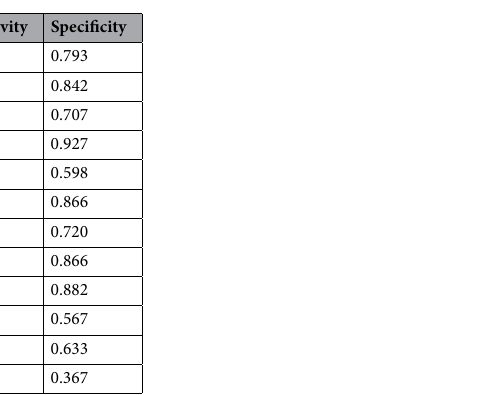
Figure 4. The diagnostic value of hsa_circ_0006423 and miR-492 in NSCLC. ( A ) AUC of hsa_circ_0006423 preoperative and healthy control groups in plasma samples. ( B ) AUC of hsa_circ_0006423 postoperative and healthy controls groups in plasma samples. ( C ) AUC of hsa_circ_0006423 preoperative and postoperation groups in plasma samples. ( D ) AUC of miR-492 preoperative and healthy control groups in tissue samples. ( E ) AUC of miR-492 postoperative and healthy controls groups in plasma samples. ( F ) AUC of miR-492 preoperative and postoperation groups in plasma samples. ( G ) AUC of hsa_circ_0006423 in tissue samples. ( H ) AUC of miR-492 in tissue samples. ( I ) Combined analysis of the AUC of hsa_circ_0006423 and miR-492 in plasma and tissue samples.